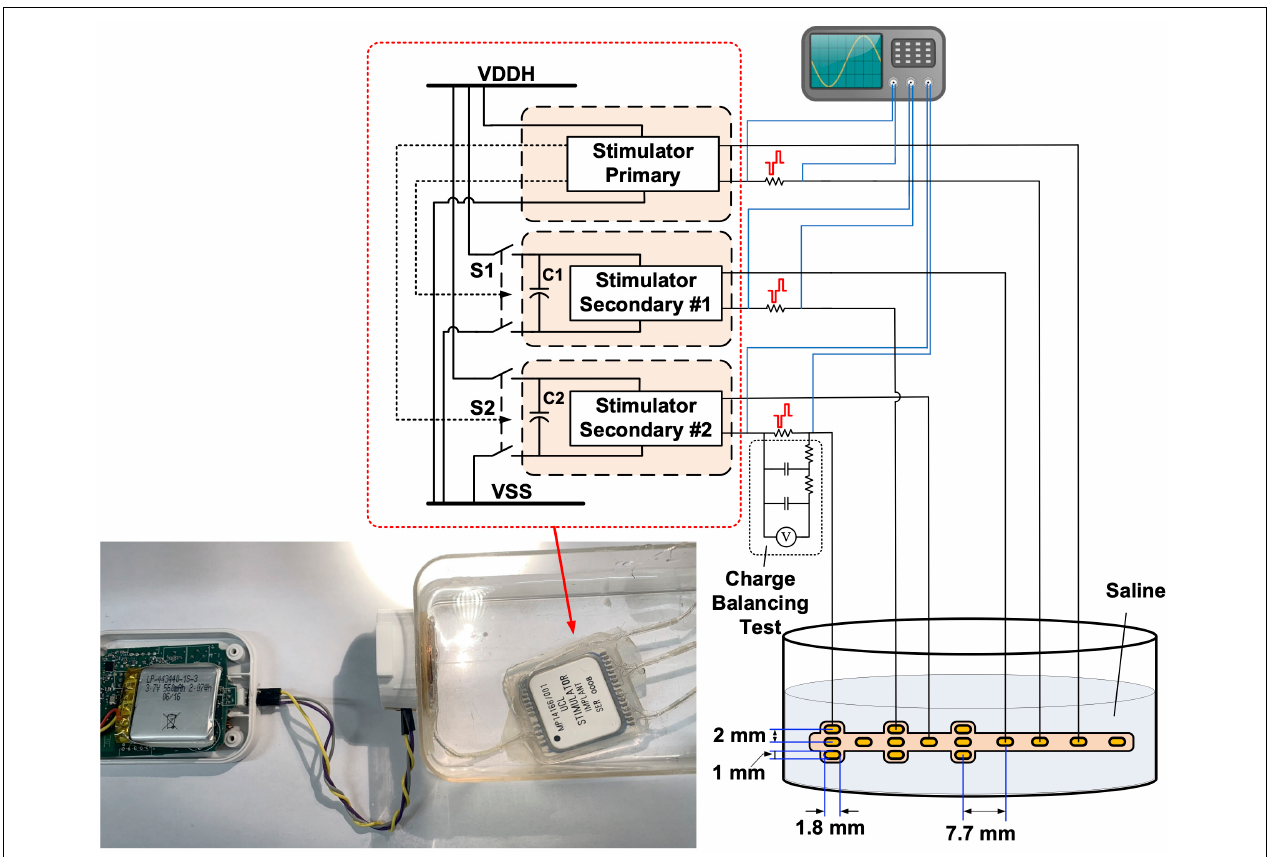
FIGURE 7 | Diagram of the in vitro benchtop performance evaluation setup. Insert: photo of the wearable transmitter and implantable stimulator during the in vitro experiment.